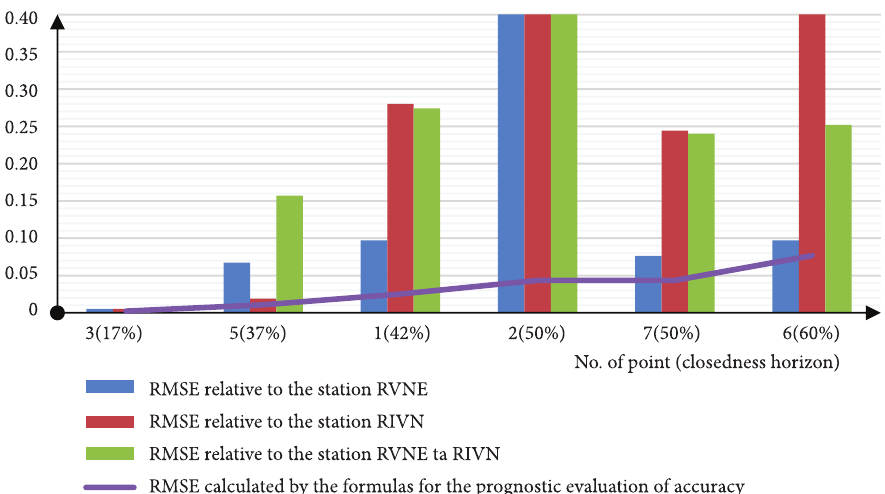
Figure 9. Comparison of RMSE of the spatial location by the session duration for 1 hour and prognostic points of accuracy evaluation calculated by Equation